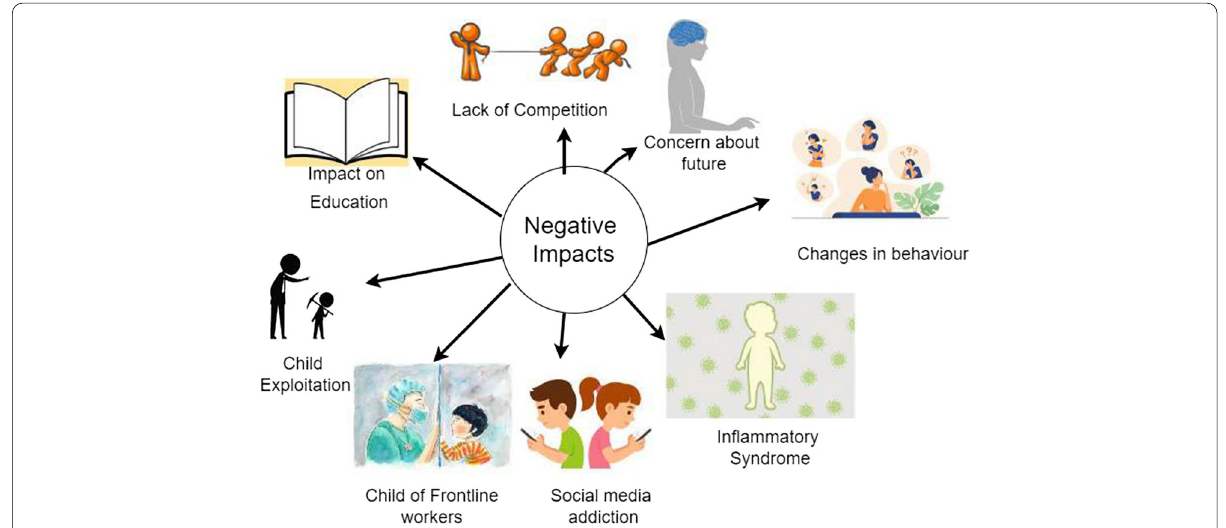
Fig. 3 Negative impacts of COVID on children, the image was drawn by the